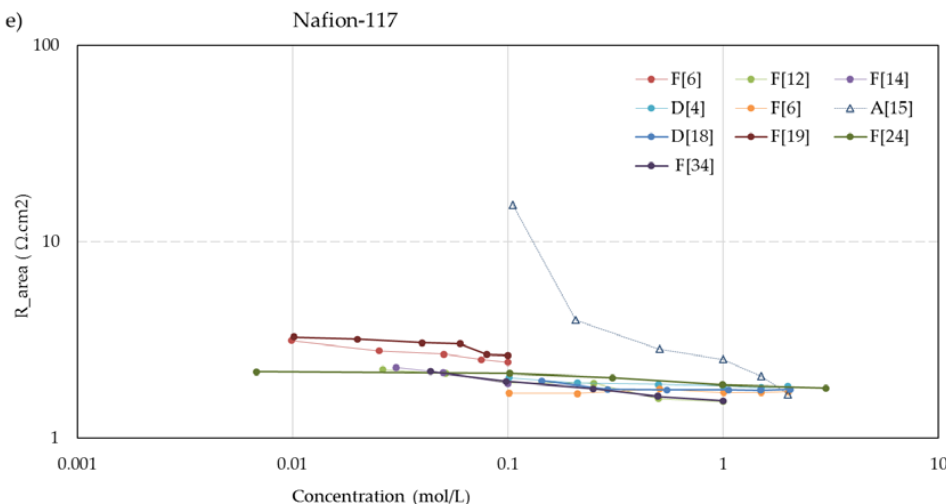
Figure 5. Resistance as a function of the bulk NaCl concentration for CMX ( a ), AMX ( b ), MK-40 ( c ), MA-41 ( d ), and Nafion-117 ( e ). The code for the measurement cell (A, B... F) and the source are listed in the legend box. Lines are added to aid visual interpretation; dashed lines in the CMX and AMX plots ( ─ ─ ● ─ ─ ) indicate experiments with a short dip of the membrane in a 5 M NaCl solution before the resistance measurement [21]. Most experiments are performed with AC and indicated ( ─ ─ ● ── ); experiments with DC are indicated by (Δ).